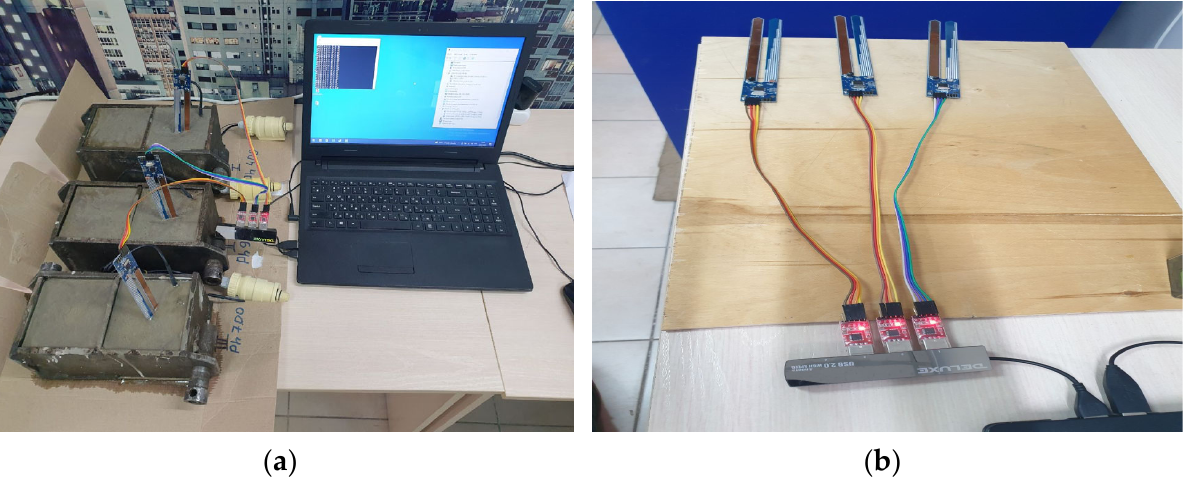
Figure 2. Experimental setup ( a ) general setup ( b ) a closer look at the connections of the sensors.